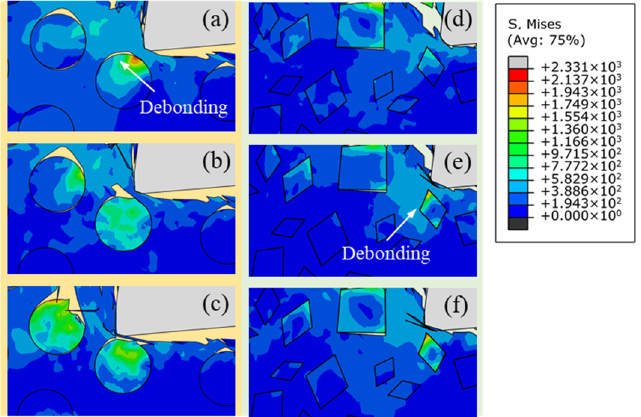
Figure 6. Stress distribution of particles on the cutting path with different particle shapes: ( a – c ) circular particles; ( d – f ) irregular polygonal particles.